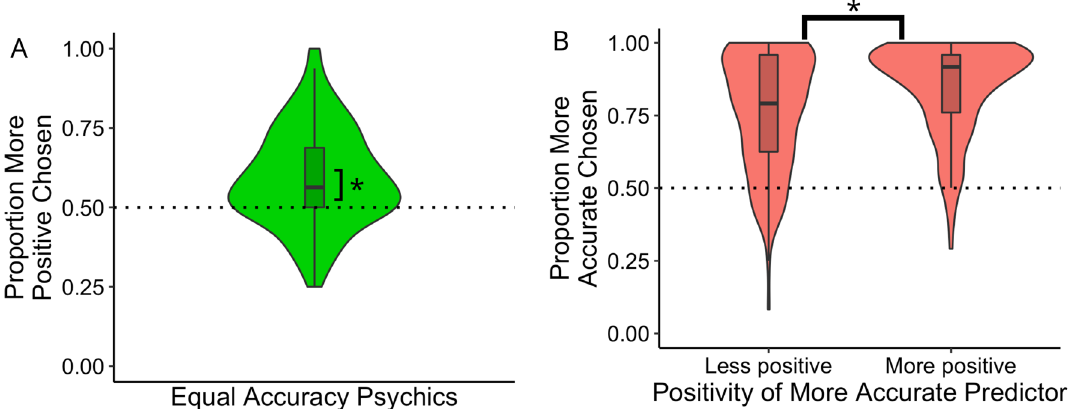
Figure 2. Behavioural results. ( A ) Trials in which the two psychics had equal accuracy in their example predictions. Plotted is the distribution of the mean proportion of trials in which participants chose to view the prediction of the more positive psychic. Asterisk denotes significant difference from chance level. ( B ) Trials in which the two psychics were not equally accurate, split by whether the more accurate psychic predicted fewer or more “win” outcomes than the less accurate psychic. Plotted are distributions of the mean proportion of trials in which the more accurate psychic was accurate psychic, t (157) = 24.29, p < 0.001. However, preference for the more accurate psychic was higher on trials in which the more accurate psychic predicted a greater number of “win” outcomes than the less accurate psychic than on trials in which the more accurate psychic predicted fewer “win” outcomes than the less accurate psychic, t (157) = 6.40, p < 0.001 (Fig. 2B).